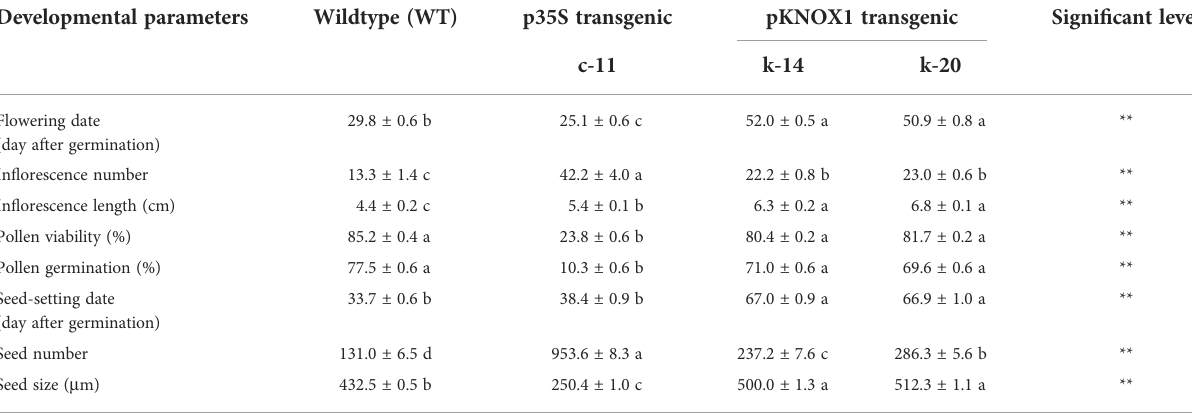
TABLE 2 The reproductive characteristics ( fl owering date, in fl orescence number, in fl orescence length, pollen viability, pollen tube germination, seed- setting date, seed number and seed size) of wildtype (WT) and transgenic lines of P. pellucida (c-11, k-14 and k-20) after 60 days of transplantation. Developmental